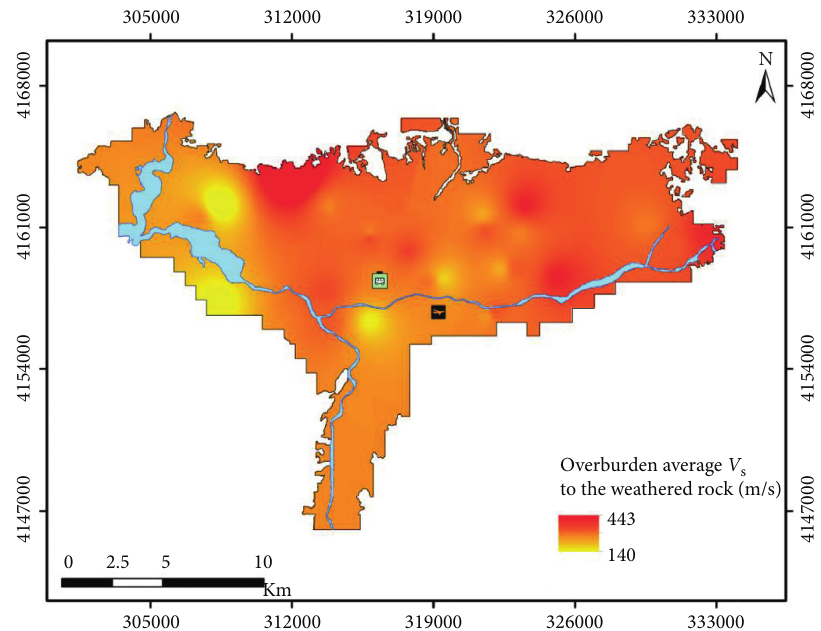
Figure 12: Average V S of overburden soil to the weathered bed rock in Kahramanmaras area.